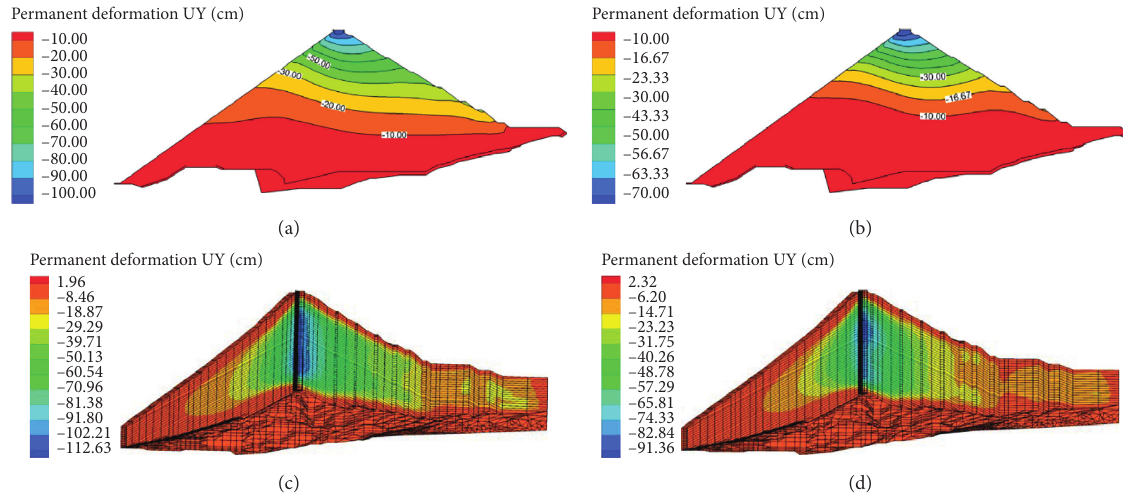
Figure 8: Permanent deformation in the vertical direction (cm). (a) A 2D view image of the distribution of permanent deformation based on UHS. (b) A 2D view image of the distribution of permanent deformation based on site-related response spectrum using scenario earthquake (SRRS). (c) A 3D view image of the distribution of permanent deformation based on UHS. (d) A 3D view image of the distribution of permanent deformation based on site-related response spectrum using scenario earthquake (SRRS). Table 4: Dynamic response analyses of the Houziyan high concrete-faced rockfill dam. Seismic